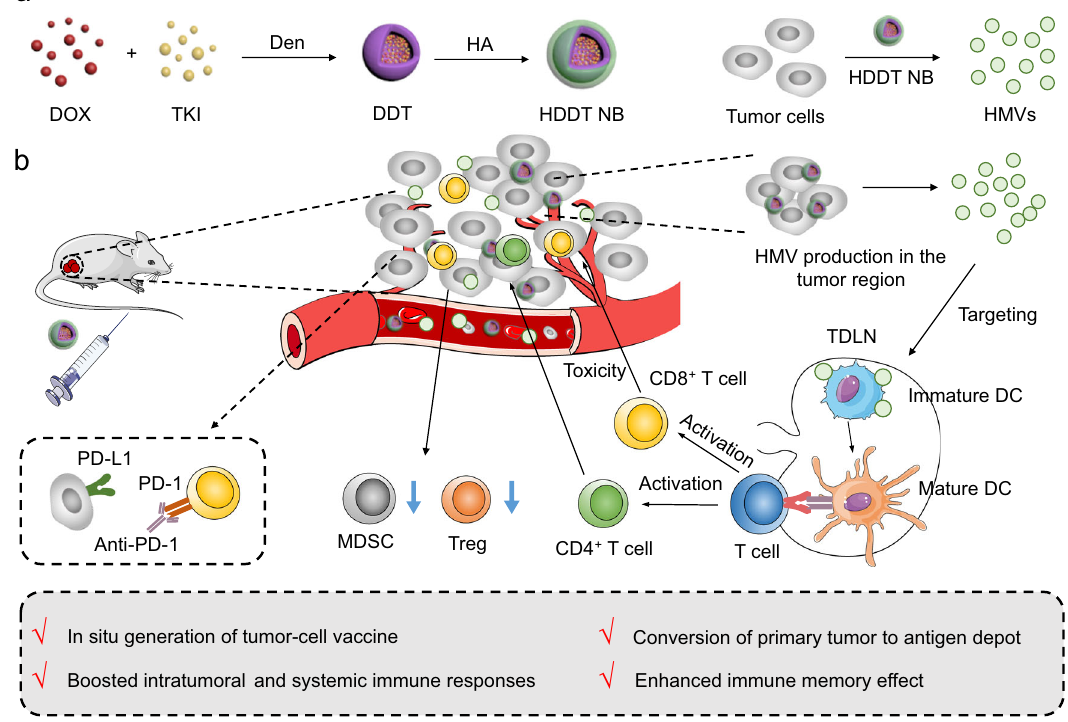
√ √ Fig. 1 | Schematic illustration of the HDDT NB-induced in situ generation of HMVs that act as autologous tumor-cell vaccines for systemic immune responses. a Fabrication of the HDDT NB and preparation of HMVs in vitro. b Scheme of the HDDT NB-induced systemic immune responses for cancer treat- ment. DOX doxorubicin, TKI tyrosine kinase inhibitor, Den dendrimer, HA